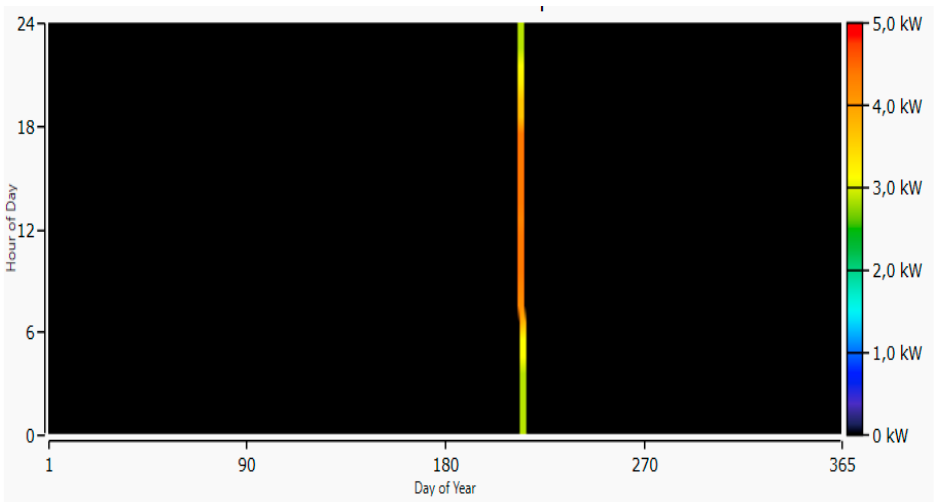
Figure 2. Grid outage for both System 1 and System 2.